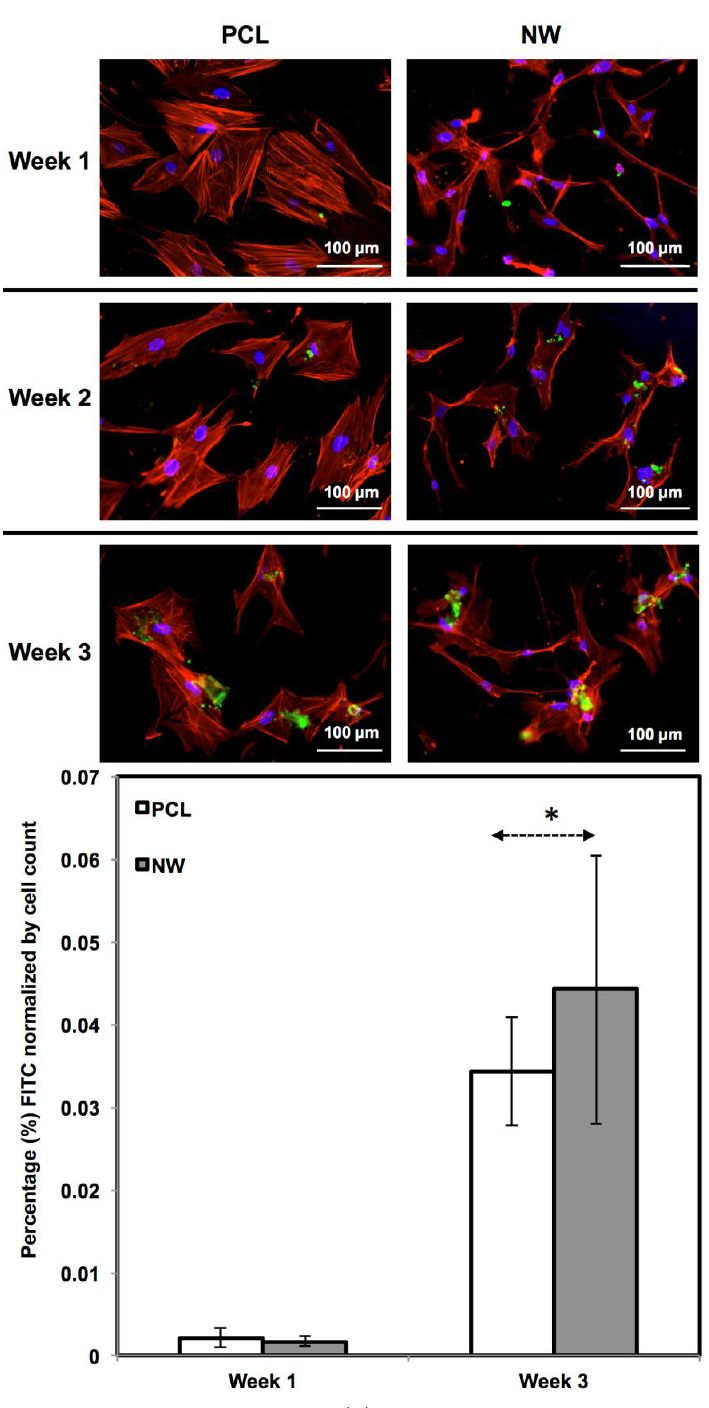
Figure 11. ( a ) Representative immunofluorescence images of ADSCs on PCL and NW for PPARγ (green), actin (red) and nuclei (blue) after 1, 2, and 3 weeks of culture in adipogenic conditions; ( b ) Representative fluorescence images of ADSCs on PCL and NW for adiponectin (green), actin (red) and nuclei (blue) after 1, 2, and 3 weeks of culture in adipogenic conditions. Percentage of FITC-labeled PPARγ ( a ) and adiponectin ( b ) were normalized by total number of cells within a particular image. Asterisks above Week 3 indicate statistical significance from Week 1 using p-value less than α =